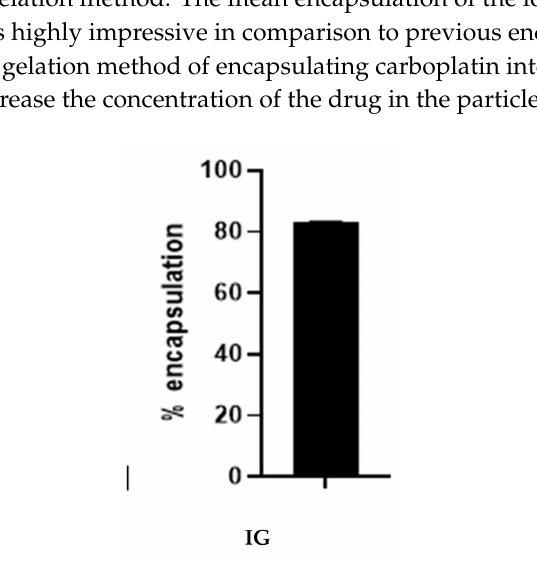
Figure 5. Percentage encapsulation of SFCP microparticles using the ionic gelation method (IG).